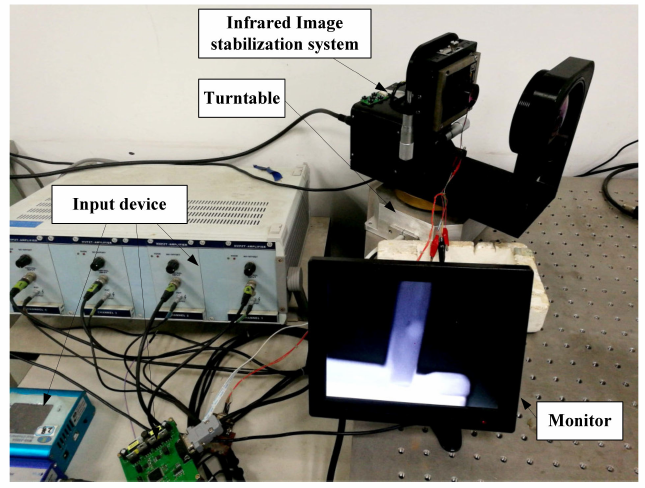
Figure 23. The test system.